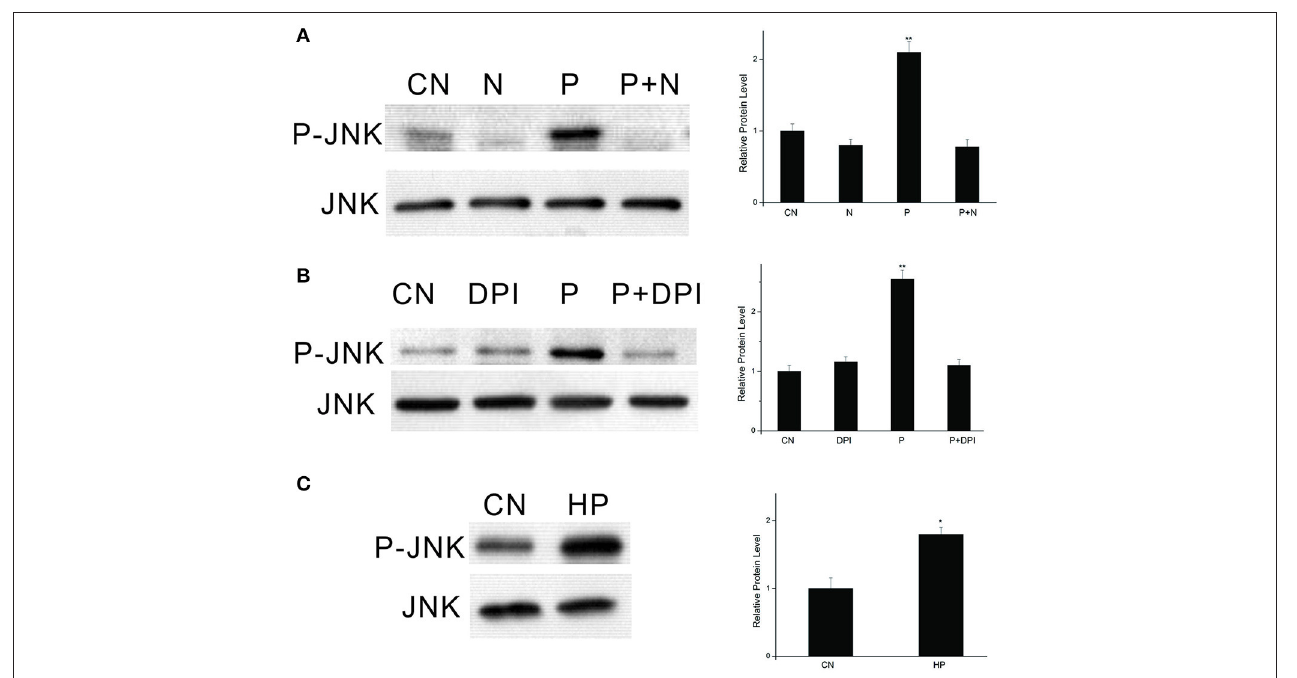
FIGURE 5 | Effects of NAC (A) and DPI (B) on PTTH-stimulated JNK phosphorylation and effect of exogenous H 2 O 2 on JNK phosphorylation (C). PGs were pretreated with either NAC (20mM), DPI (10 µ M), or vehicle alone for 30min, and then transferred to medium containing the same dose of the inhibitors, with or without the PTTH. Incubation was maintained for 60min. CN, PGs incubated in control medium; N, PGs incubated in medium containing NAC only; P, PGs incubated in medium containing the PTTH only; P + N, PGs incubated in medium containing both the PTTH and NAC; DPI, PGs incubated in medium containing DPI only; P + DPI, PGs incubated in medium containing both the PTTH and DPI; HP, PGs treated with H 2 O 2 (1mM). Gland lysates were prepared and subjected to an immunoblot analysis with anti-phospho-JNK (P-JNK) and anti-JNK (JNK) antibodies. Results shown in the left panels are representative of three independent experiments. Data are expressed as multiples of change over the respective control after being normalized to the JNK level. Asterisks indicate a significant difference compared to the respective control (by Student’s t -test, * p < 0.05; ** p < 0.01).